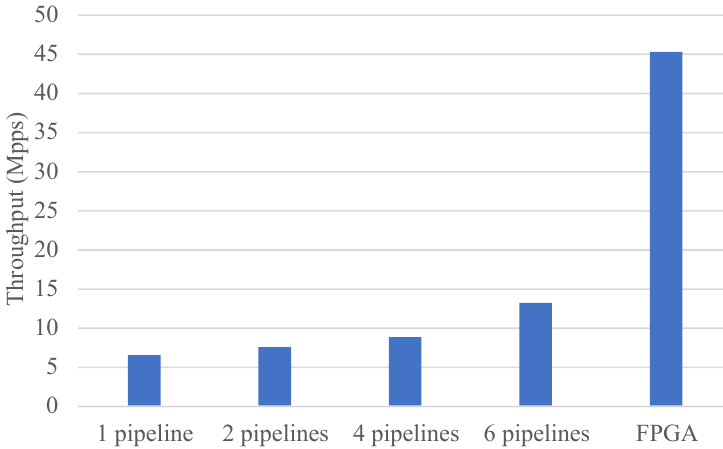
Figure 11. The throughput comparison of the CPU and